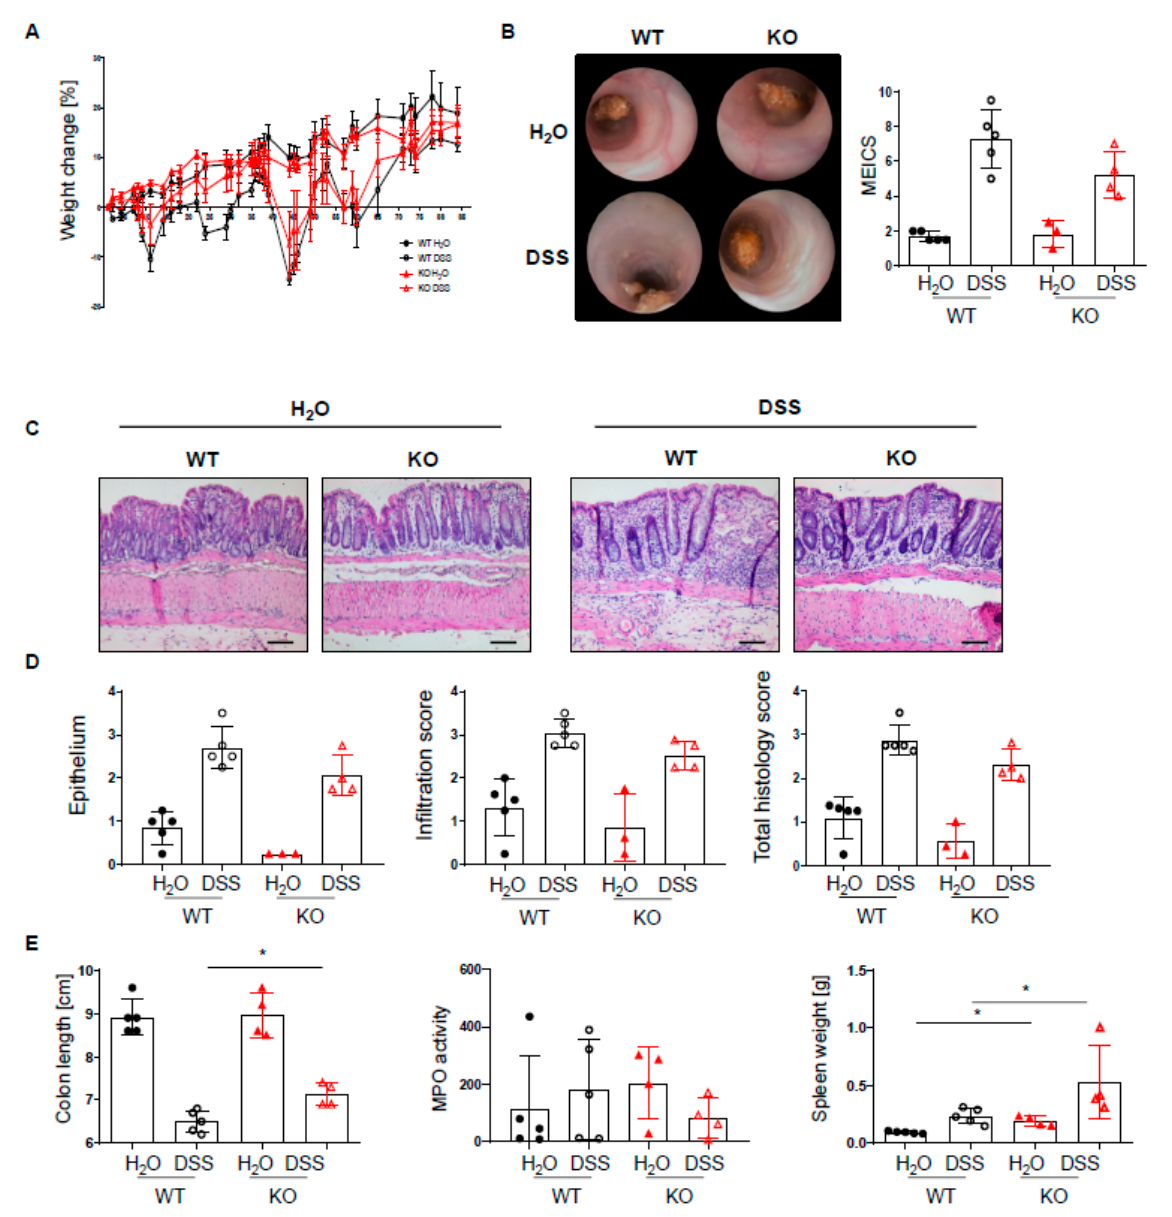
Figure 5. PTPN2 fl/fl xCD11c Cre mice tend to develop a less pronounced chronic inflammation. PTPN2 fl/fl (WT) and PTPN2 fl/fl xCD11c Cre (KO) mice received 4 cycles of DSS (7 days of 1.5% DSS followed by 10 days with normal drinking water) and were analyzed 4 weeks after the last DSS administration: ( A ) relative weight changes; ( B ) representative pictures from colonoscopy and assessment of murine endoscopic index of colitis severity (MEICS); ( C , D ) representative pictures from H&E staining of the terminal colon and histological scoring; ( E ) colon length, spleen weight, and MPO activity. Scale bars represent a length of 100 mm. * p < 0.05; unpaired Mann–Whitney test. Data are representative for one out of two independent experiments with 5 mice per experimental group.